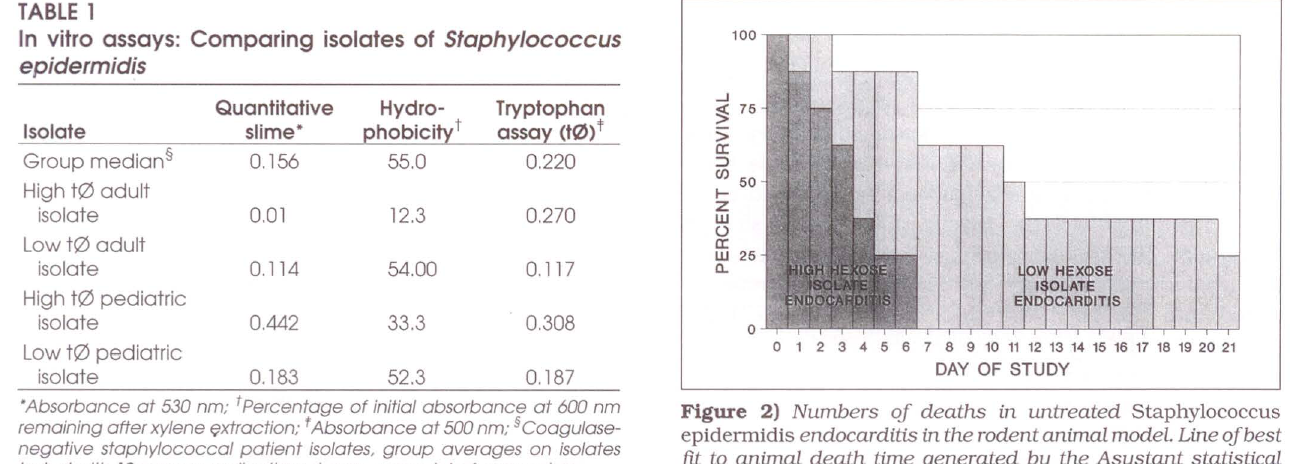
Figure 2) Numbers of deaths in untreated Staphylococcus epidennidis endocarditis in the rodent animal modeL Line of best fit to animal death time generated by the Asystant statistical package. The difference between groups was significant (P<0.025)